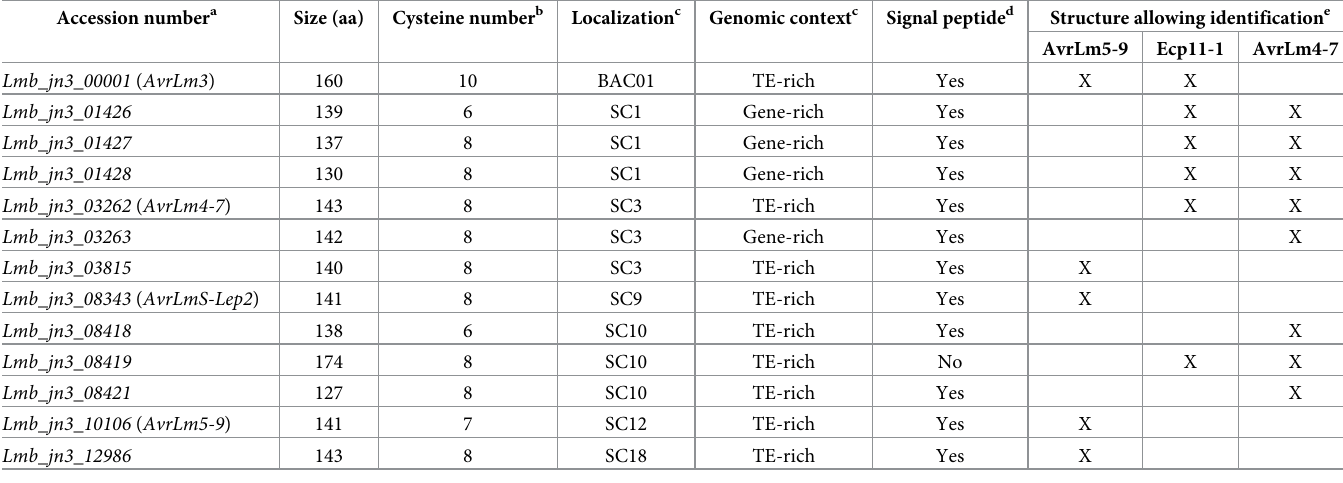
Table 1. Characteristics of the structural analogues identified in L . maculans . Accession number a